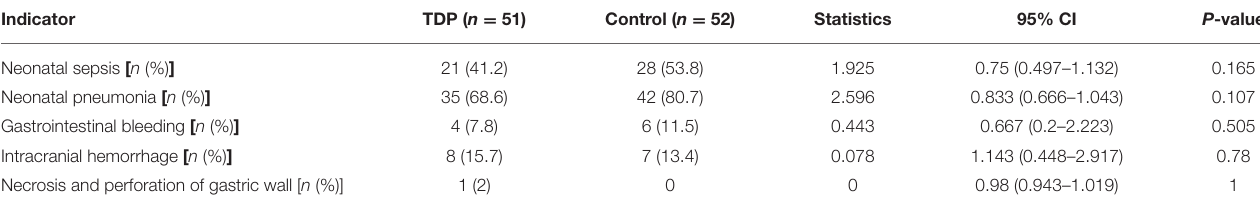
TABLE 3 | Comparison of complications and coexisting diseases between the two groups.